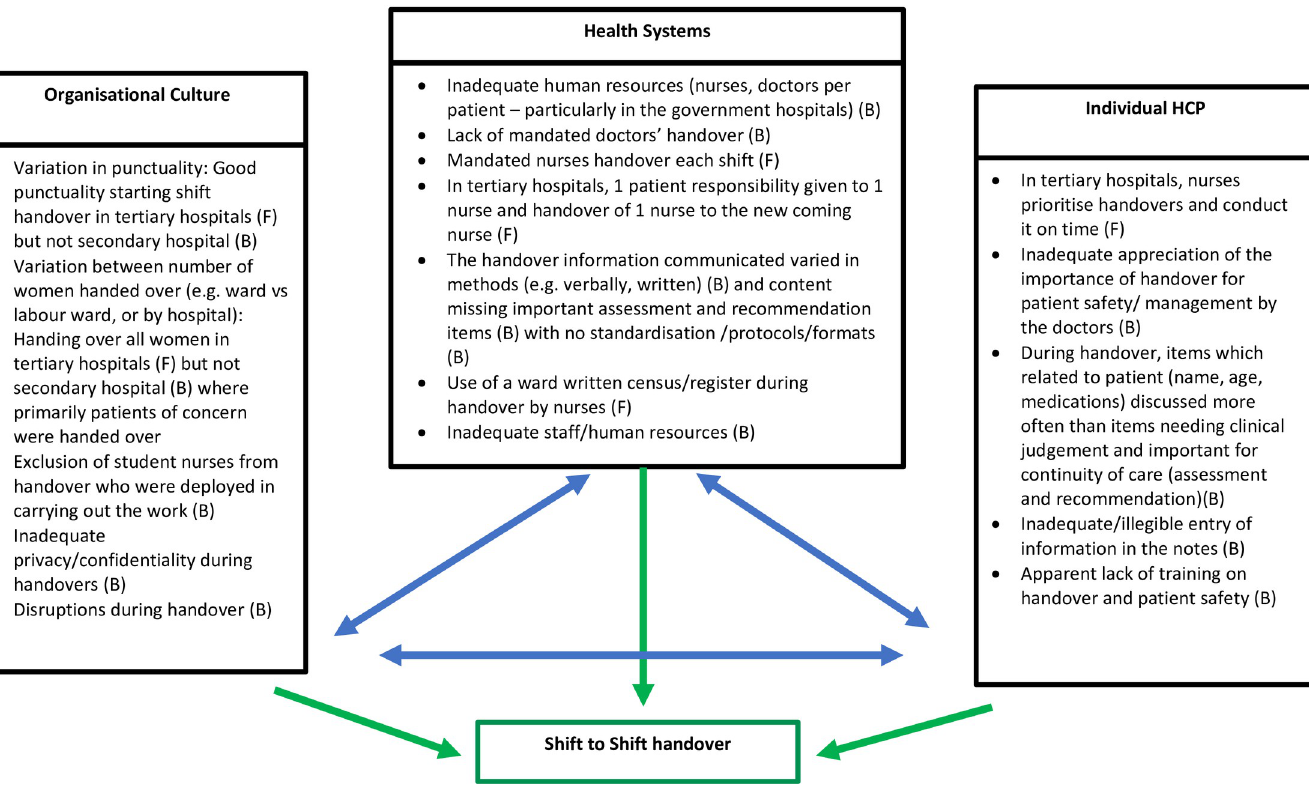
Fig 2. The factors influencing quality of maternity handover. Figure outlining the factors influencing quality of maternity handover in our study. Health systems, organisational culture and individual healthcare professionals (HCP) can affect each other. One factor may have numerous dimensions that can be reflective of multiple influences. Additionally, all three factors influence the shift- to- shift handover. B = Barrier, F = facilitator.